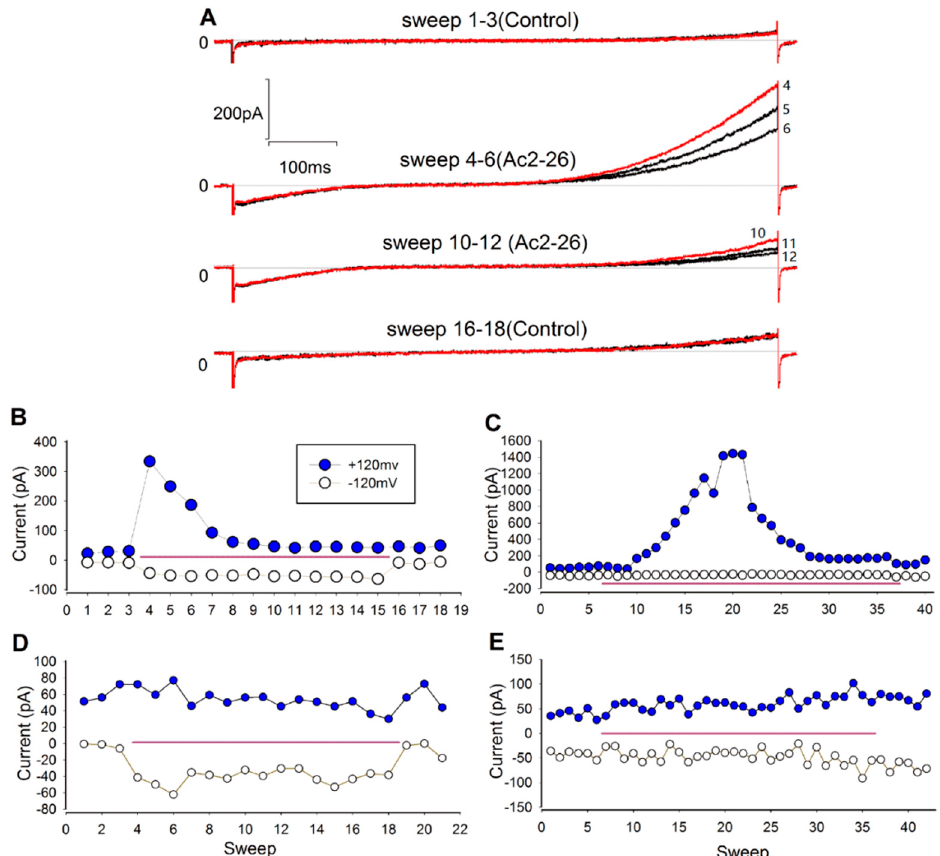
Figure 6. Ac2-26 treatment increased the amplitude of cell membrane currents in BV-2 cells. ( A ) Representative current traces illustrate that Ac2-26 (3.3 μ M) increased both the inward current (I i ) and the outward current (I o ). The stimulus protocol was ramp voltage (Figure S2); the red lines are first trace in the groups; ( B – E ) the instantaneous values at +120 and − 120 mV from the current curves recorded using ramp voltage indicate different types of responses to Ac2-26 treatment (3.3 μ M). Pink lines mark the period of Ac2-26 application in the bath; ( B ) both I i and Io were significantly increased after Ac2-26 treatment; ( C ) example of a cell in which only Io was significantly increased after Ac2-26 treatment; ( D ) example of a cell in which only I i was significantly increased after Ac2-26 treatment; ( E ) example of a cell in which neither I i nor Io were significantly affected by Ac2-26 treatment.